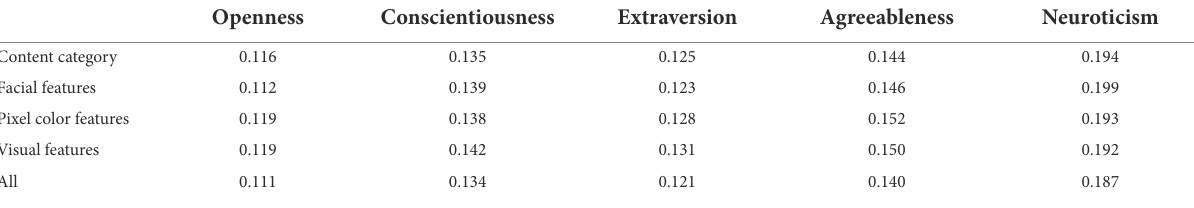
TABLE 4 Root mean square errors in 10-fold cross validation of random forest regression on personality